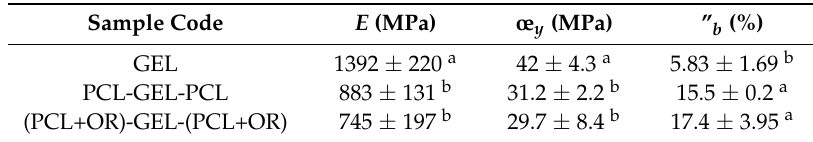
Table 4. Tensile parameters ( E : Tensile Modulus, σ y : Tensile Strength at yield and ε b : Elongation at Break) of Gelatin, PCL-Gel-PCL, and (PCL+OR)-GEL-(PCL+OR) films.